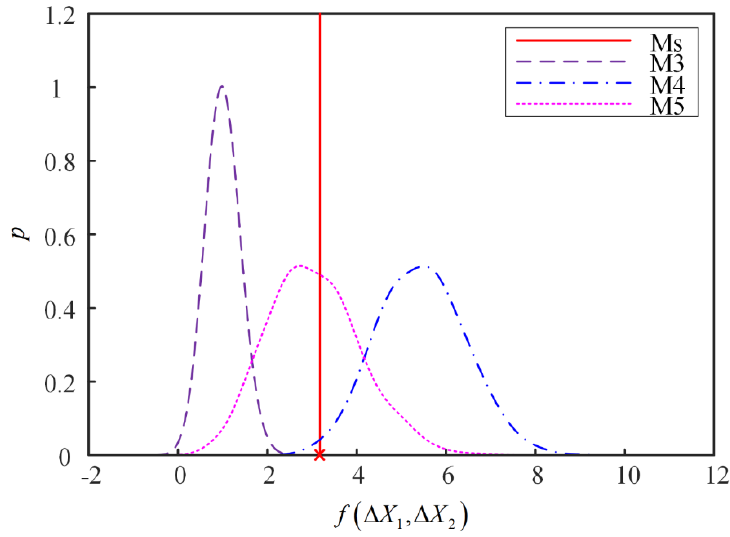
Figure 7. Failure probability distribution function for three different models.